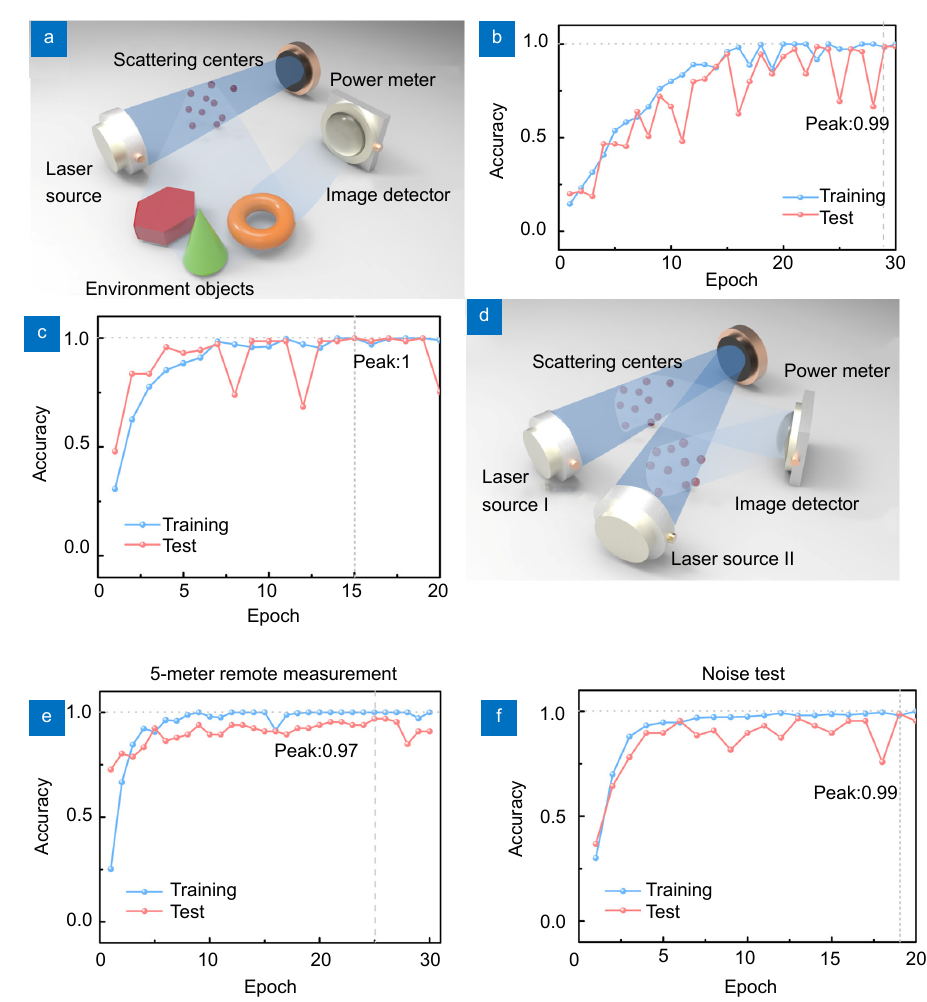
Fig. 3 | Accuracy of the inverse sensing in different conditions. ( a ) Schematic of the CNN DL method to measure the intensity of the laser beam by analyzing the scattered photon on the surrounding objects. The incident light beam is completely beyond the field of view; Experimental results of the accuracy corresponding to the ( b ) measurement without the incident light beam in the field of view (peak value 0.99), and ( c ) sim- ultaneous monitoring of two incident laser beams with one single CMOS (peak value 1). ( d ) Schematic of the CNN DL to measure two incident laser beams. ( e , f ) Experimental results of the accuracy corresponding to the remote detection and noise test,